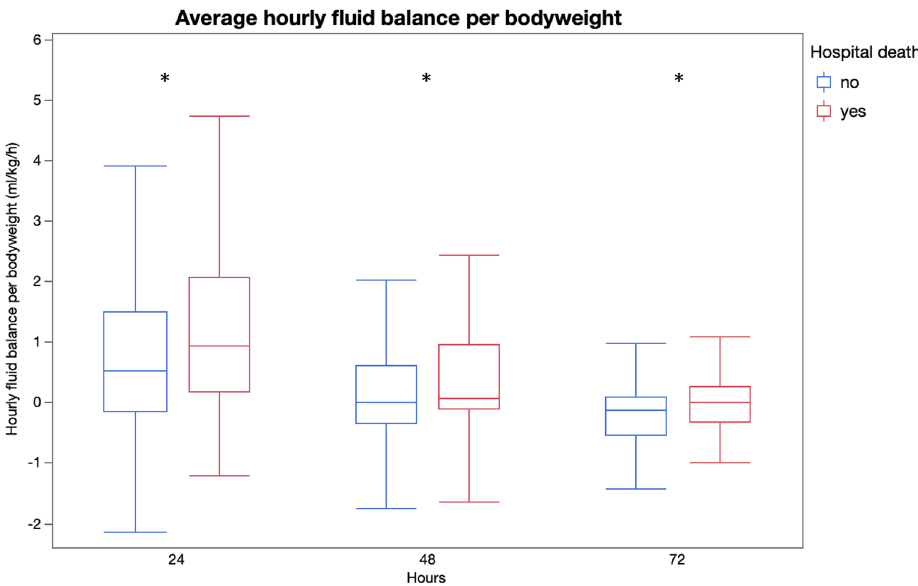
Figure 1. Hourly fluid balance by time (*p < 0.01, **p < 0.001). The figure was generated using JMP Pro 15.1.0 software. Copyright 2019 © SAS Institute Inc. JMP Pro and all other SAS Institute Inc. product or service names are registered trademarks or trademarks of SAS Institute Inc., Cary, NC, USA.